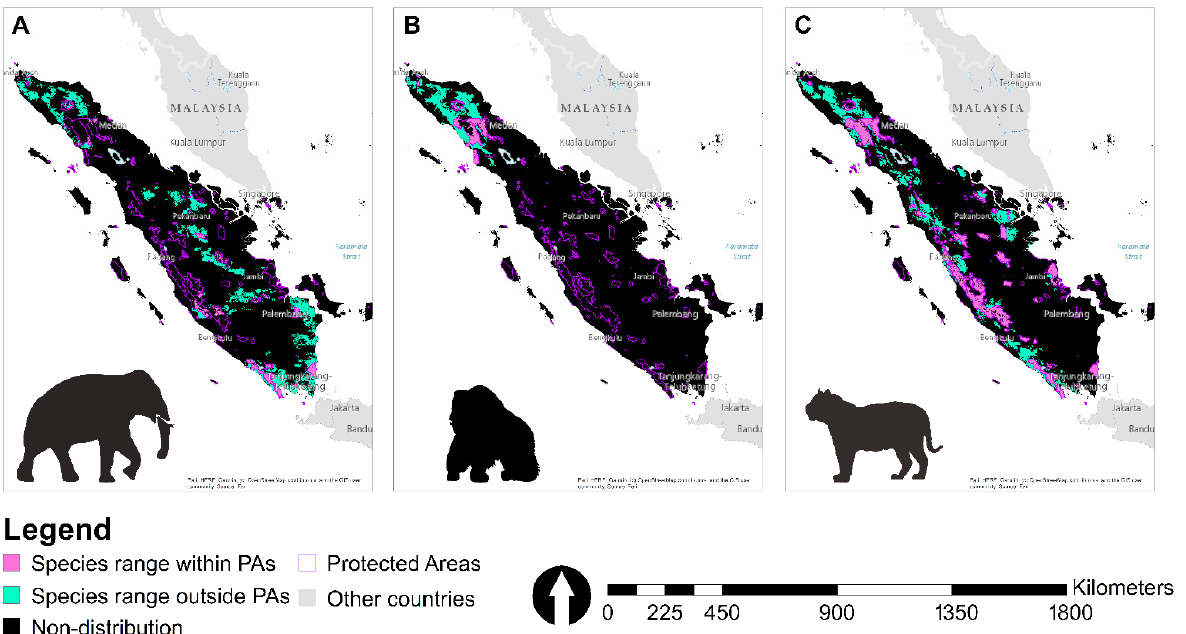
Figure 3. Predictive maps of areas suitable for native populations of E.m. sumatranus ( A ), P. abelii ( B ), P.t. sumatrae ( C ). P.t. sumatrae ( C